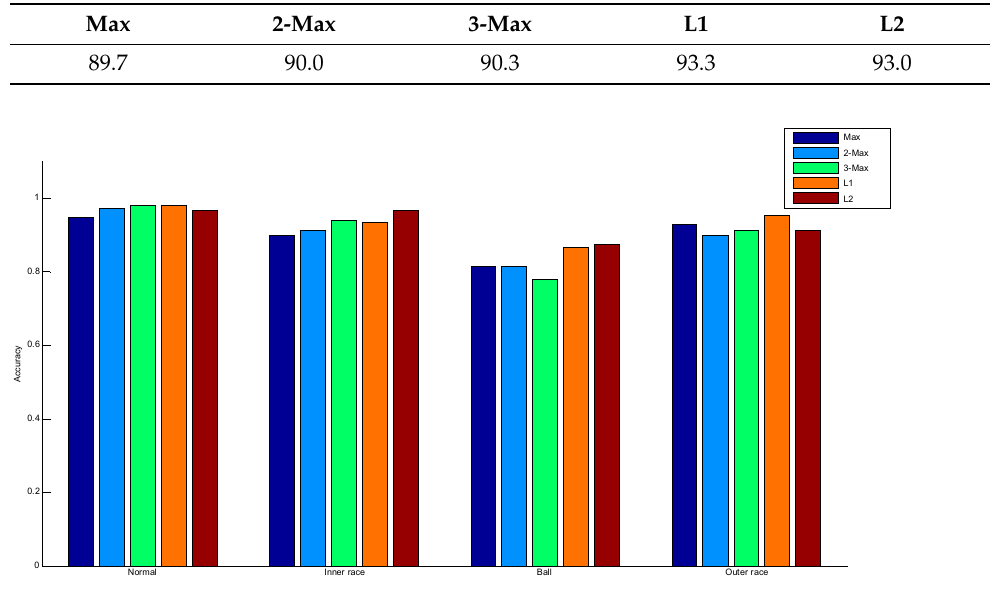
Figure 8. Diagnosis results in detail.